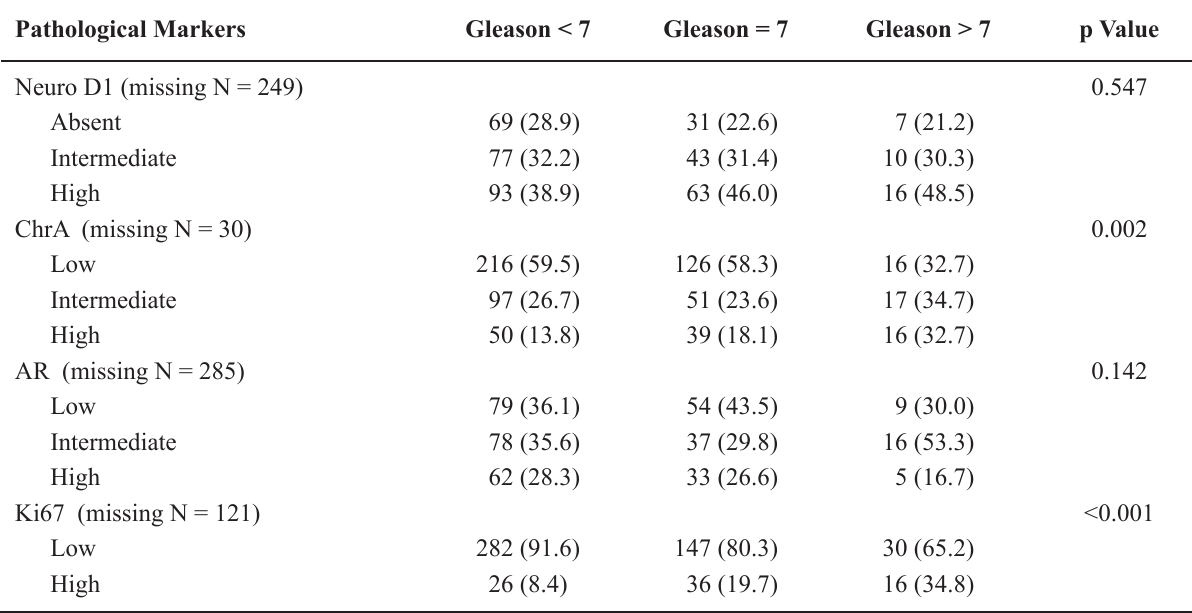
* tables entries are absolute numbers and percentages. ChrA = chromogranin-A; AR = androgen receptor; Ki67 = Ki67 label index.